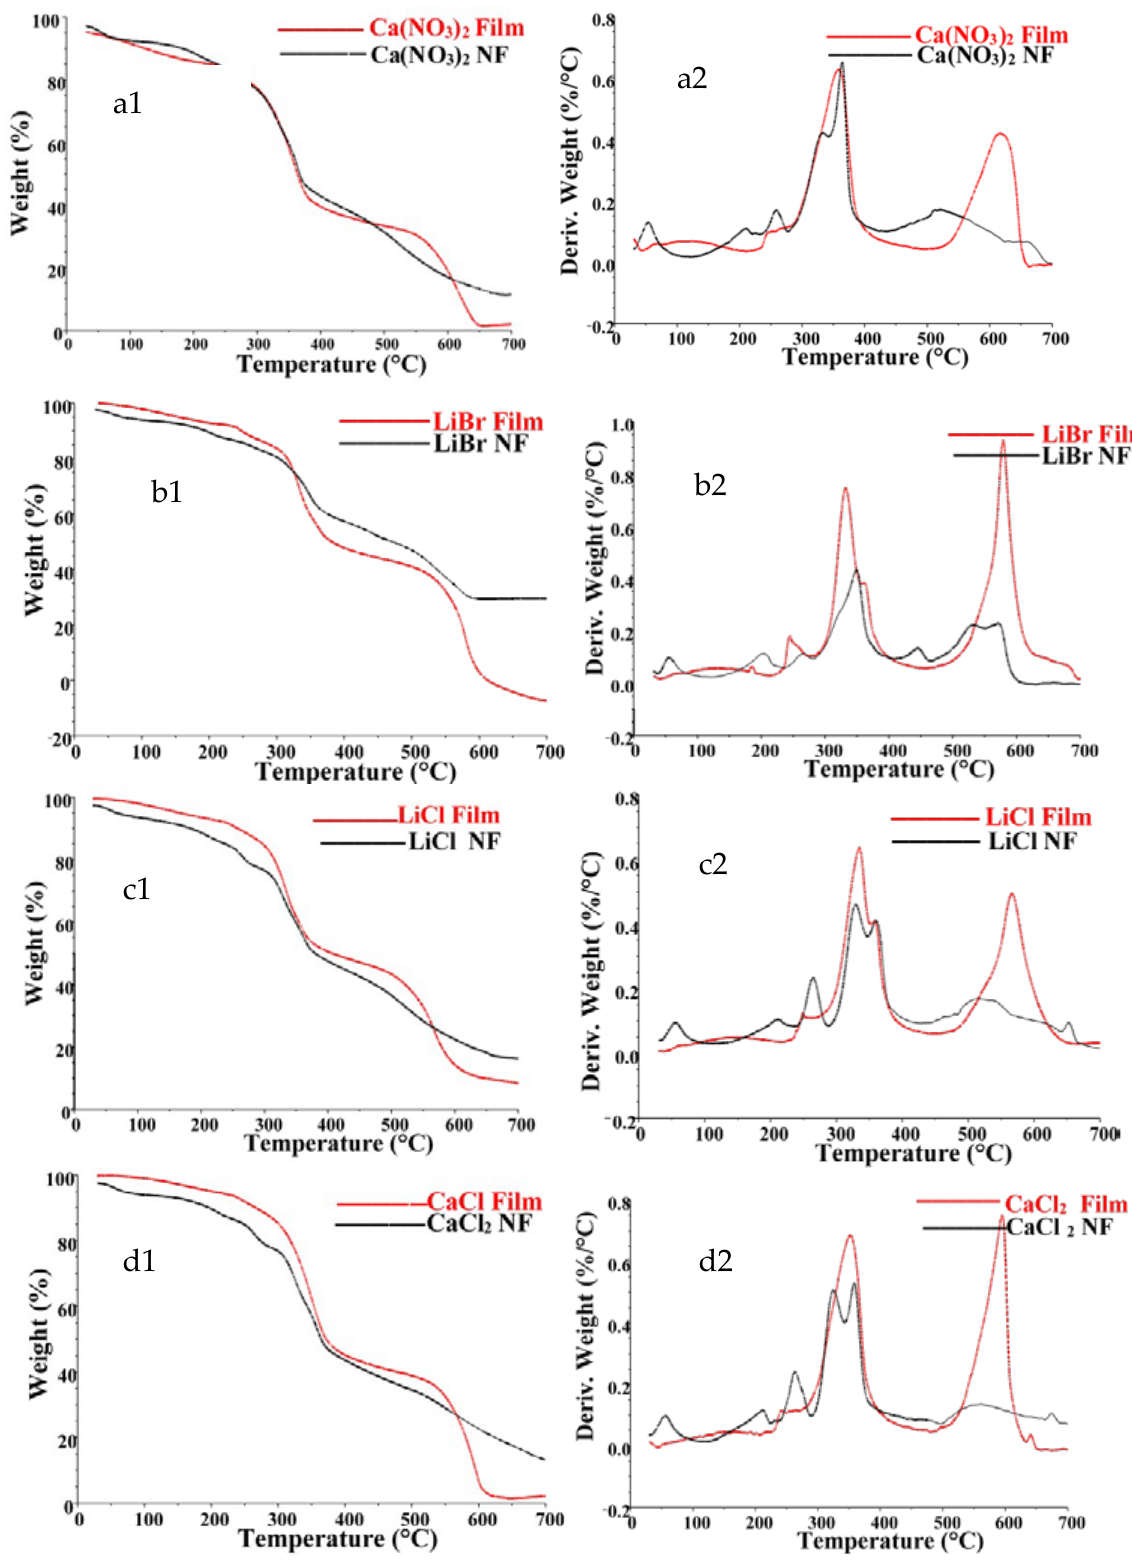
Figure 13. TG curves of ( a1 ) Ca(NO 3 ) 2 , ( b1 ) LiBr, ( c1 ) LiCl, and ( d1 ) CaCl 2 . And corresponding derivative TG curves